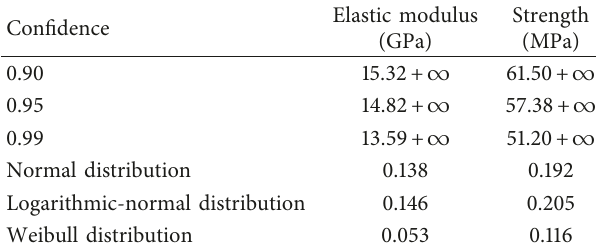
Table 2: Confidence levels for the strength and elastic modulus of